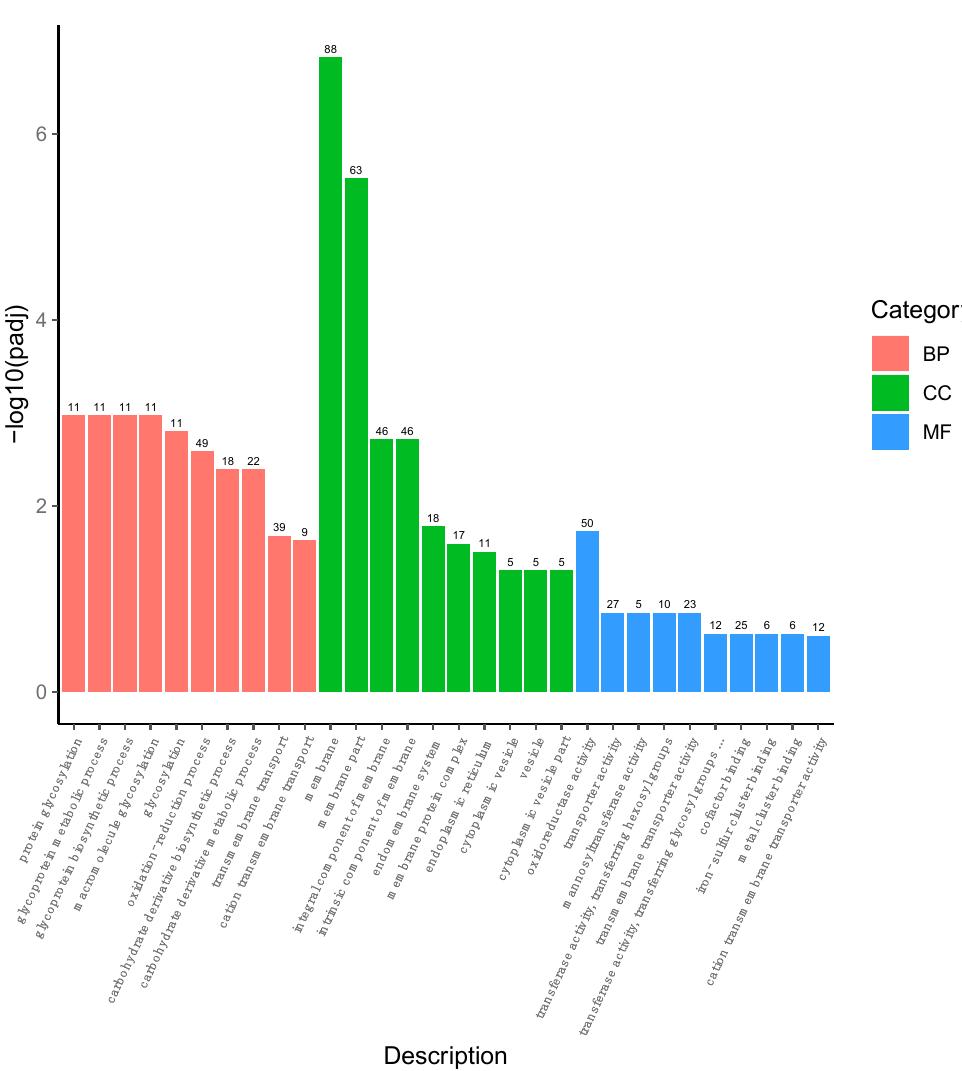
Figure 5. Categorization of GO function for DEGs in P. pastoris cells. The ordinate ( − log10 (padj)) represents the significance level of GO term enrichment, and the numbers above the graphs indicate the number of genes differentially expressed; p -values < 0.05 were designated as differentially expressed genes (DEGs).